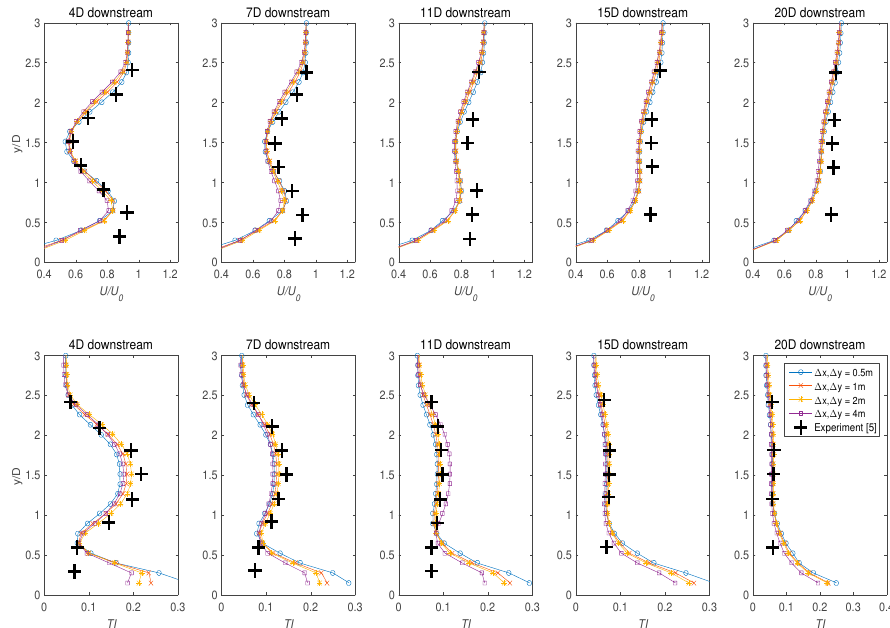
Figure 11. The influence of the structured grid density ( ∆ x & ∆ y ) on the flow using the non-hydrostatic approximations. The vertical resolution ∆ z and the disc thickness ∆ x t were maintained at 24 sigma layers and 2 m, respectively for all cases.